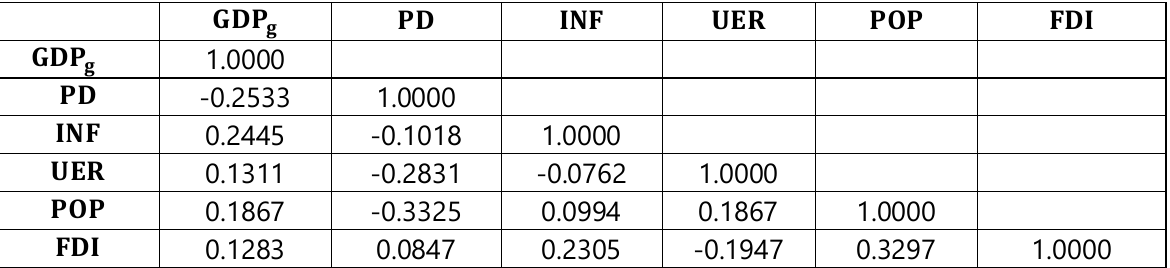
Table 3: Correlation Analysis (Source: Authors’